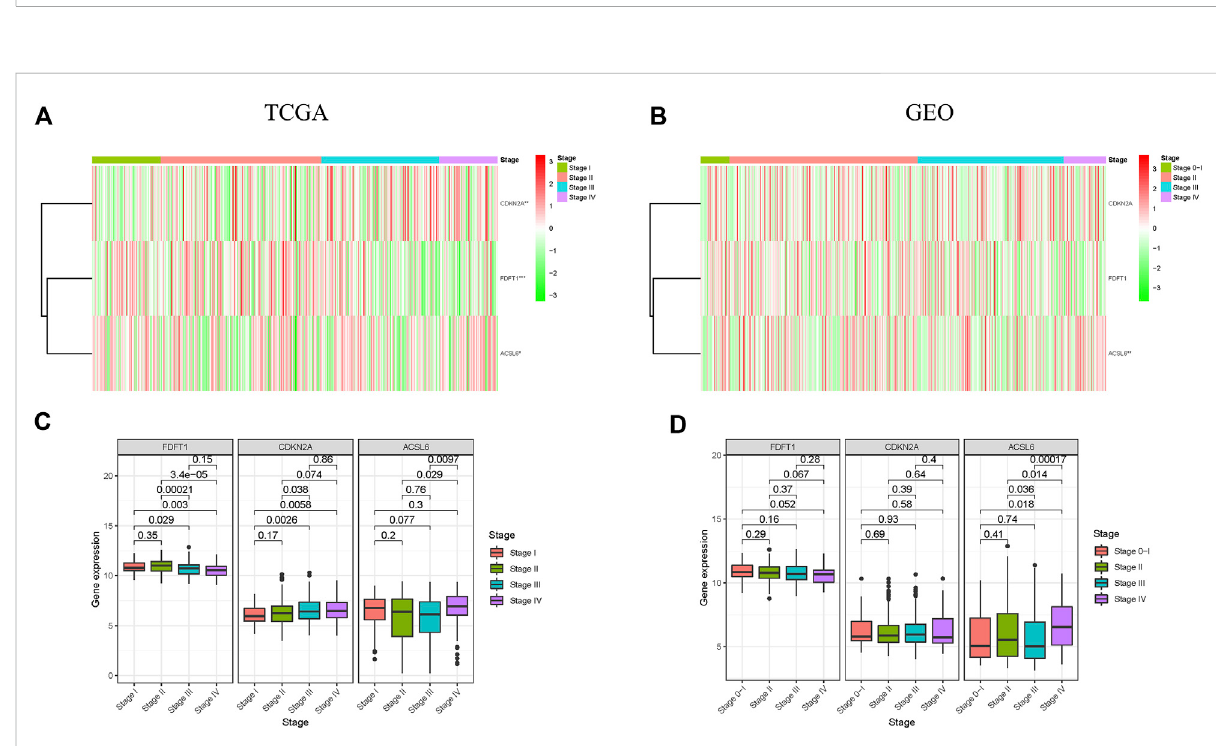
FIGURE 5 Correlation between ferroptosis-associated gene expressions and clinicopathological features in CRC patients. (A,B) Expression patterns of 3 ferroptosis-associated genes in different stages in TCGA and GEO cohorts; (C,D) Expression levels of 3 ferroptosis-associated genes in CRC at different stages in TCGA and GEO cohorts. * p < 0.05, ** p < 0.01, and *** p <